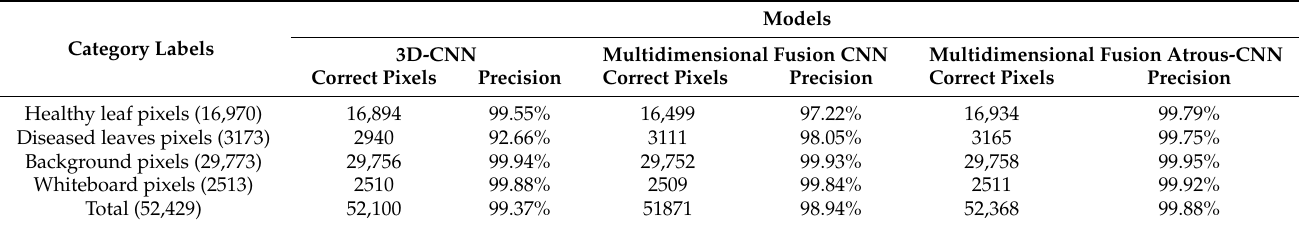
Table 4. Test results of three network models.